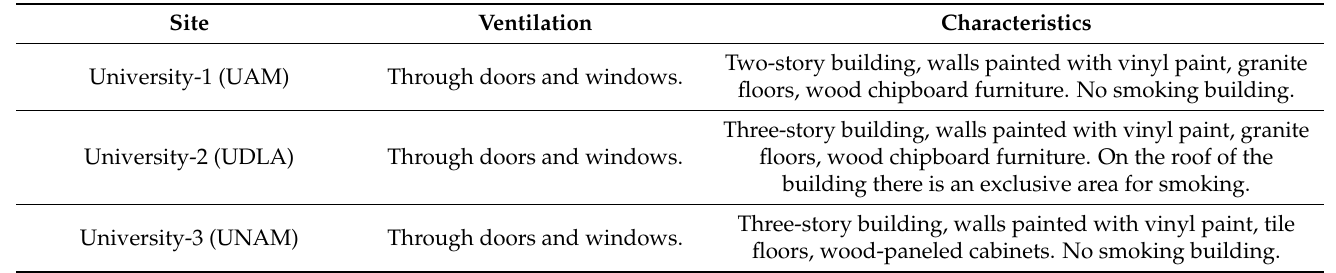
Figure 1. Location and geographical characteristics of the study sites. Table 1. Characteristics of the study sites: University-1 (UAM), University-2 (UDLA) and University-3 (UNAM).